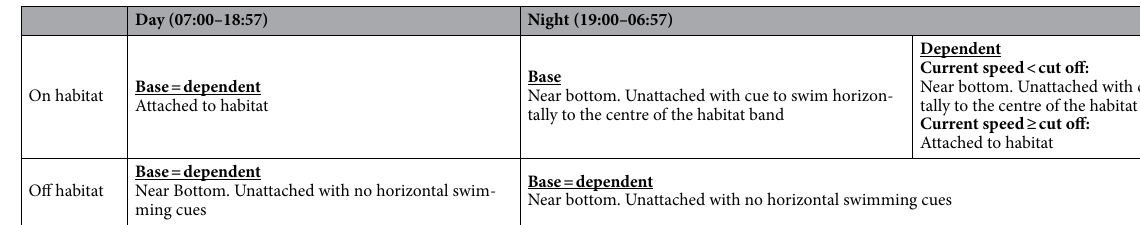
Base Base = dependent Near bottom. Unattached with cue to swim horizon- Attached to habitat tally to the centre of the habitat band Base = dependent Base = dependent Off habitat Near Bottom. Unattached with no horizontal swim- Near bottom. Unattached with no horizontal swimming ming cues Table 1. Descriptions of the base and dependent models of Copula Sivickisi medusae behaviour. The behaviour of medusae in the base model was determined by the time of day (day or night) and the location of medusae in relation to reefal habitat. An additional behaviour was added to the dependent model where medusae only swam at night if the current speed at their location was less than a set cut off. When medusae swam, their speed was set to their critical swim speed (U crit ; 4.9 cm s −1 ) or their sustainable swim speed (U sust ; 2.45 cm s −1 ).